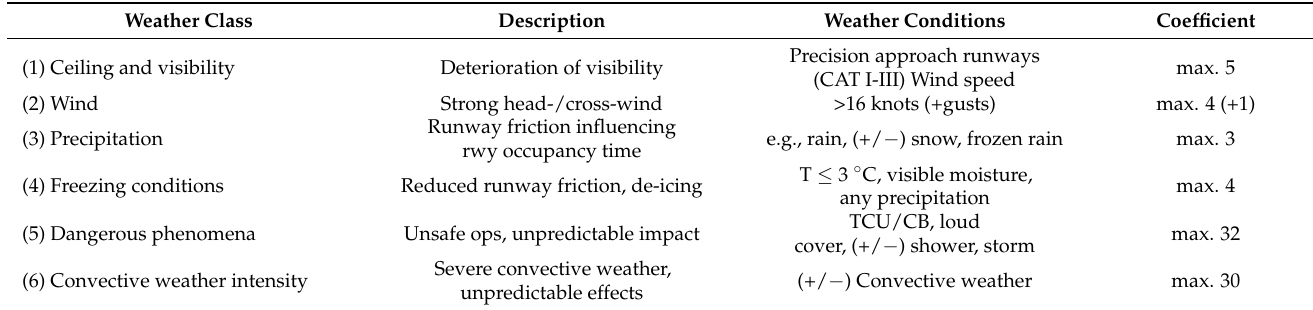
Table 2. Relevant weather scoring standards in TAWQM